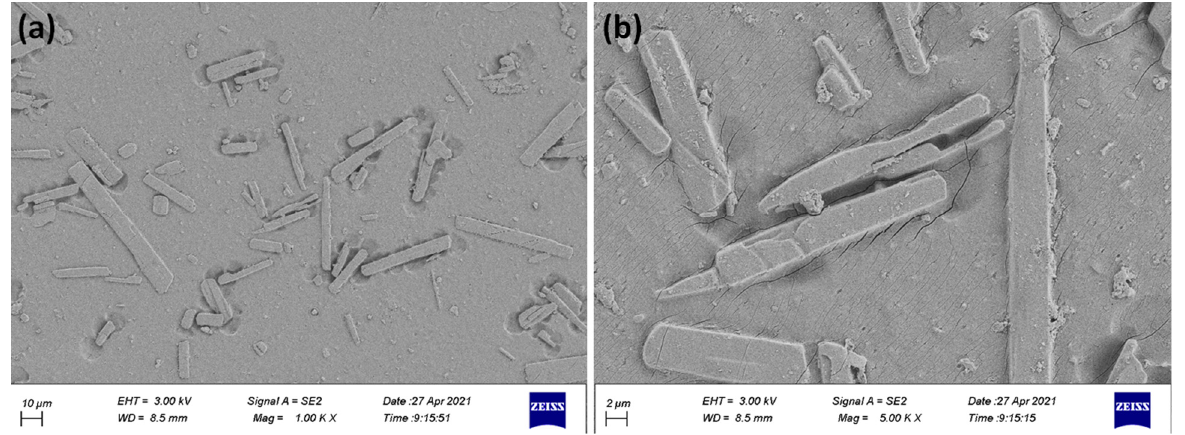
Figure 7. FESEM images of PVC + 1 films after irradiation ( a ) 1× and ( b ) 5× magnification.